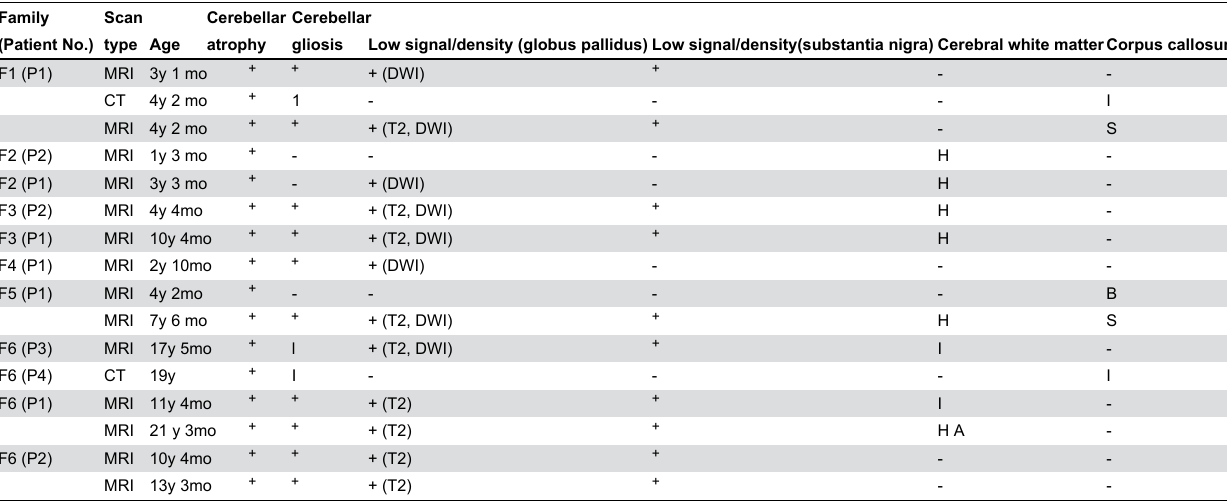
Table 5. Neuroimaging findings in 11 patients with PLA2G6 mutations.